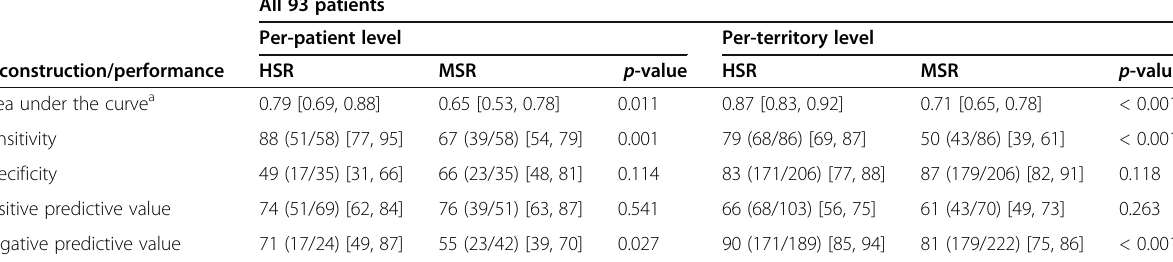
Table 3 All patients: diagnostic performance of MSR and HSR of myocardial CTP All 93 patients